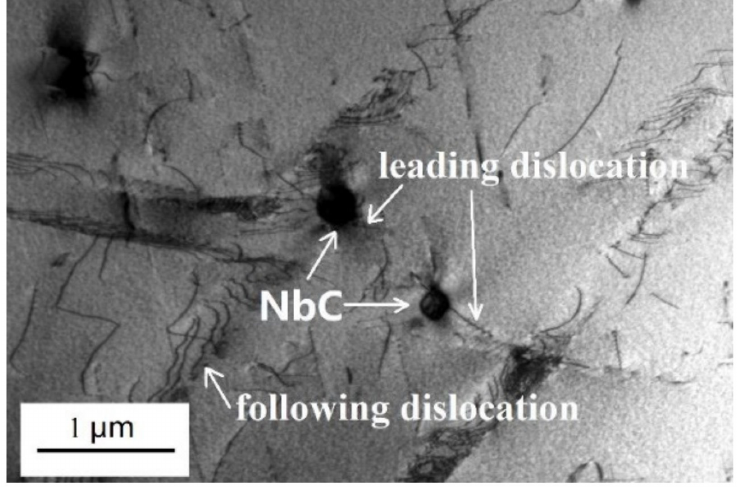
Figure 2. Interaction between dislocations and precipitates in 0.5Nb low-density steel at 5% strain